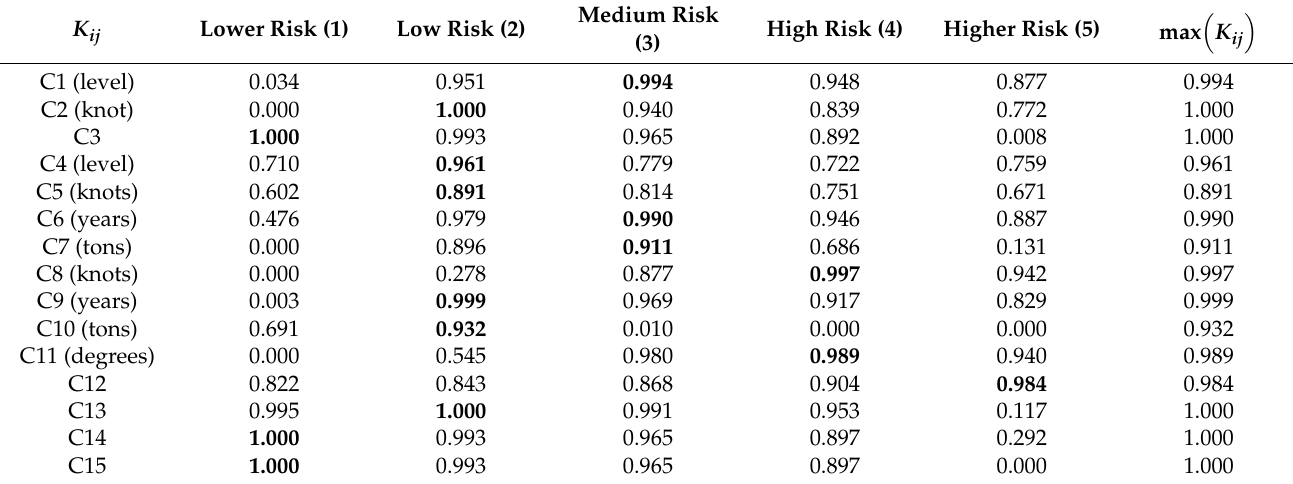
Table 9. Relevance of indicator data of “WAN HAI 316” to each level of the cloud model. (The bold value in the table represents the final risk level of the